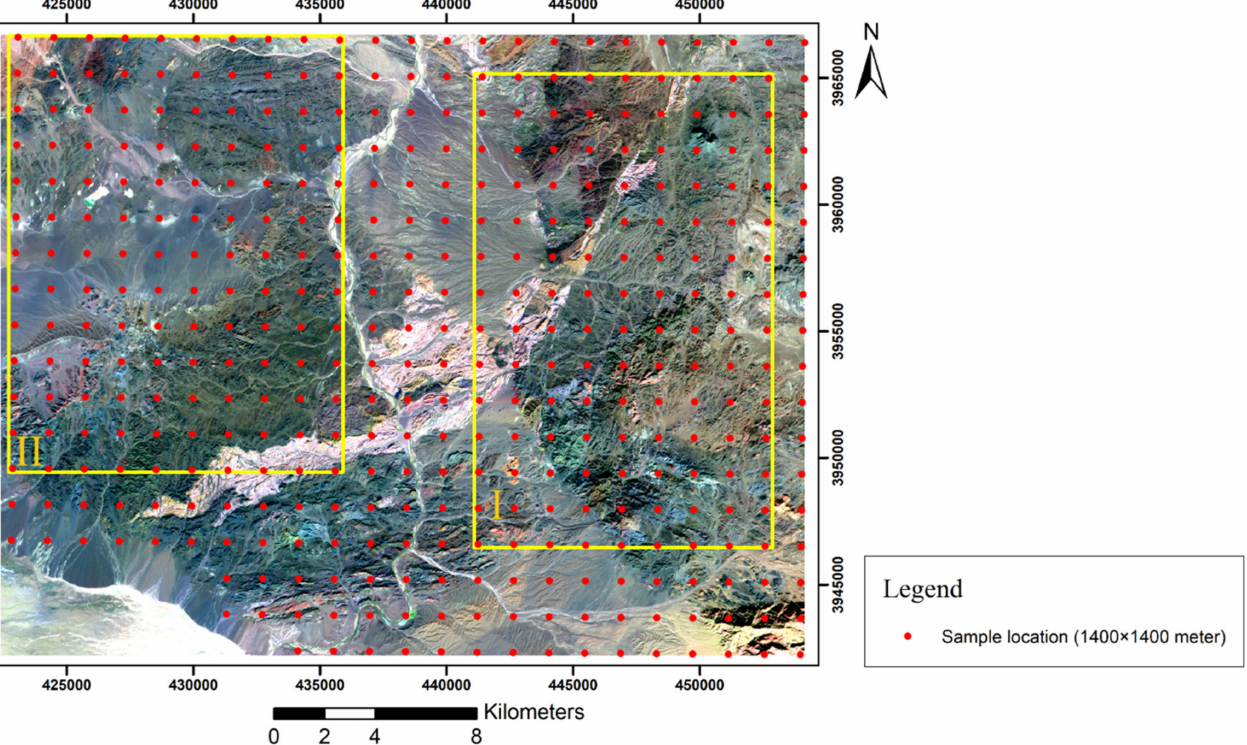
Figure 2. Geochemical sampling network in the study area (the false-color composites of Sentinel-2 MSI; band 12 in red, band 8 in green, and band 2 in